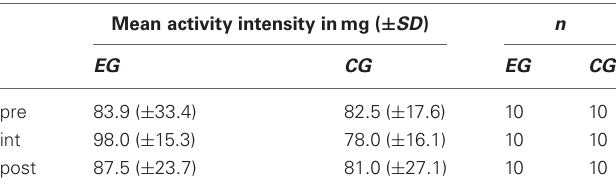
Table 1 | Mean activity intensity (mg) for EG and CG during the three periods (pre, int, and post) of activity